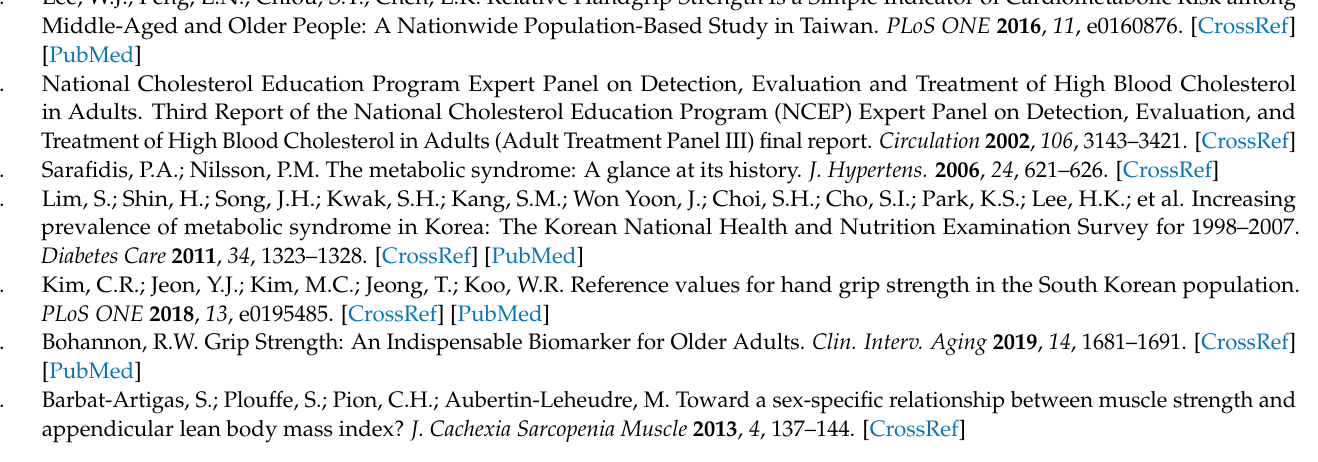
Table S6. Univariate hazard ratio (HR) of incident metabolic syndrome components associated with one standard deviation increase in mean hand grip strength, back muscle strength, and relative muscle strength according to